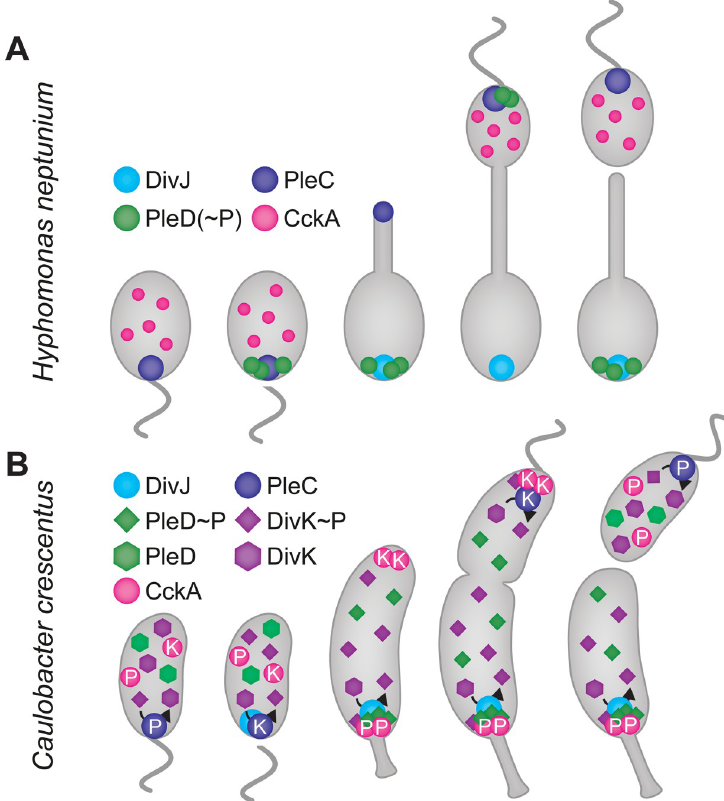
Fig 13. Localization patterns of cell cycle regulatory proteins in H . neptunium and C . crescentus . (A) Localization patterns in H . neptunium . Similar to its C . crescentus homolog, the H . neptunium histidine kinase/phosphatase PleC localizes to the flagellated pole of the swarmer cell and then relocates to the new pole once stalk formation initiates. Concomitant with the relocation of PleC, the histidine kinase DivJ localizes to the old (previously flagellated) pole, where it remains until cell division takes place. The predicted hybrid guanylate cycle/response regulator PleD first colocalizes with PleC at the flagellated pole and then relocates to the nascent bud to colocalize with DivJ. The histidine kinase CckA, by contrast, is initially dispersed throughout the swarmer cell membrane. As the cell cycle progresses, it condenses in the bud compartment but, unlike its C . crescentus homolog, never forms a distinct polar focus. (B) Localization patterns in C . crescentus . PleC localizes to the flagellated pole of the swarmer cell, acting as a phosphatase (P) that dephosphorylates DivK. Once the cell sheds the flagellum and starts to progress through its cell cycle, it switches from the phosphatase to the kinase (K) mode and relocates to the newly flagellated pole. DivJ, by contrast, localizes to the stalked pole, where it cooperates with PleC to maintain DivK in the phosphorylated state. CckA forms clusters that are randomly distributed throughout the swarmer cell envelope. At later stages of the cell cycle, it localizes to the stalked and flagellated poles, where it acts as a phosphatase (P) and kinase (K), respectively.